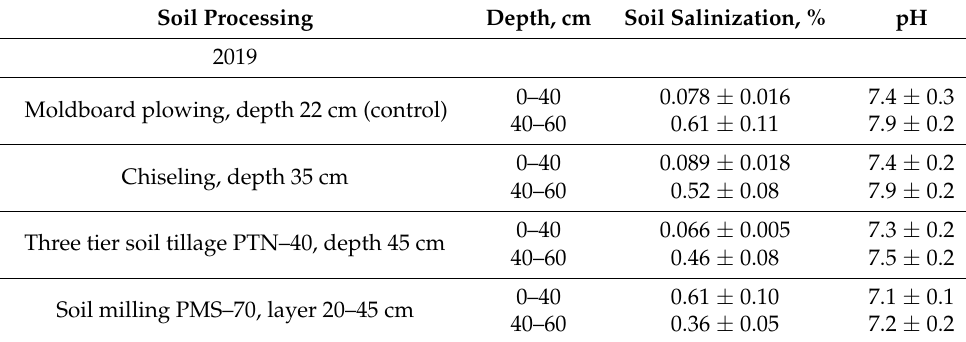
Table 7. Soil chemical properties after different options of mechanical treatment. Soil Processing Depth, cm Soil Salinization, % pH 2019 0–40 0.078 ± Moldboard plowing, depth 22 cm (control)